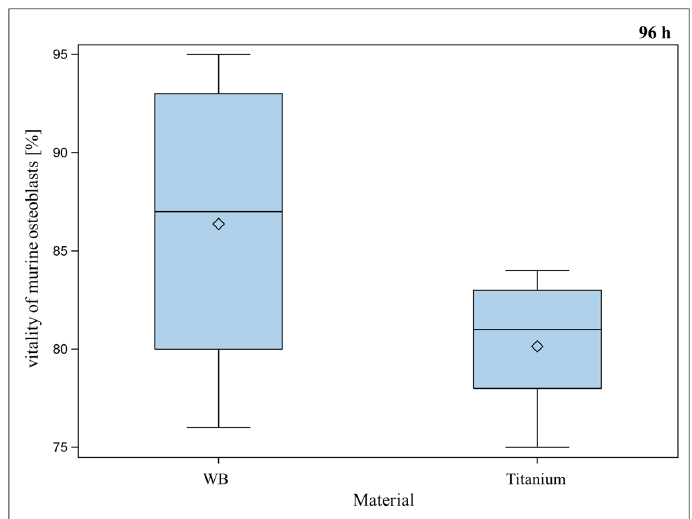
Figure 4. Vitality (%) of murine osteoblasts settled on porous titanium implants with 600 µm pore-size compared to vitality (%) of murine osteoblasts settled on WB (well bottom) for 96 h. Although WB showed a slightly better vitality, Global F -test from the analyses of variance followed by pairwise multiple means comparisons with the Least Significant Difference test did not show a significant difference between WB and titanium implant ( * = p ≤ 0.05, n = 8; rhombus = mean; centered line = median).